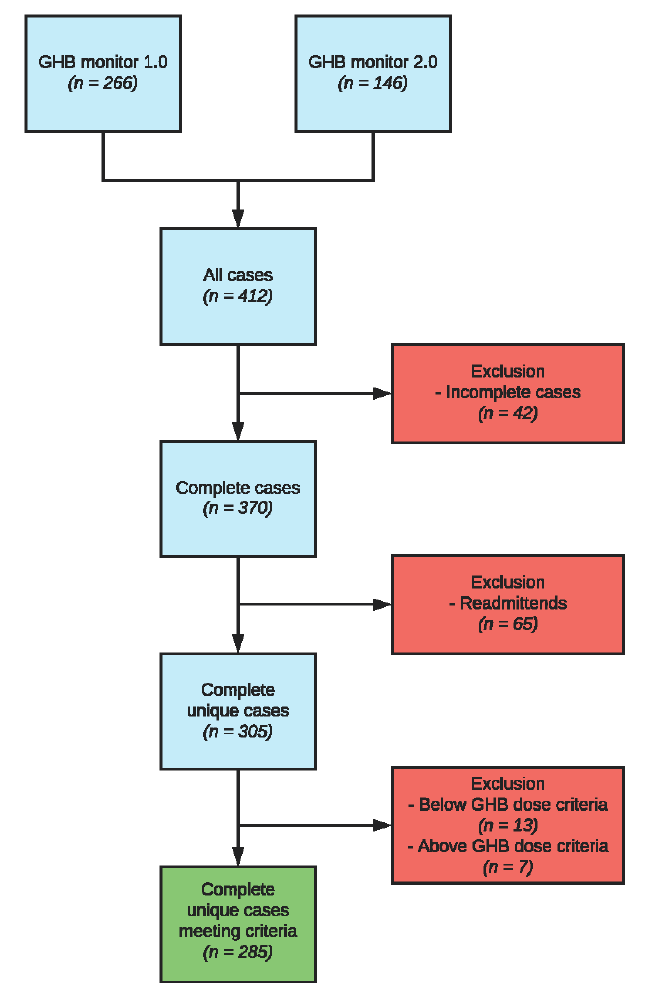
Figure 1. Flowchart of participants included in the study.